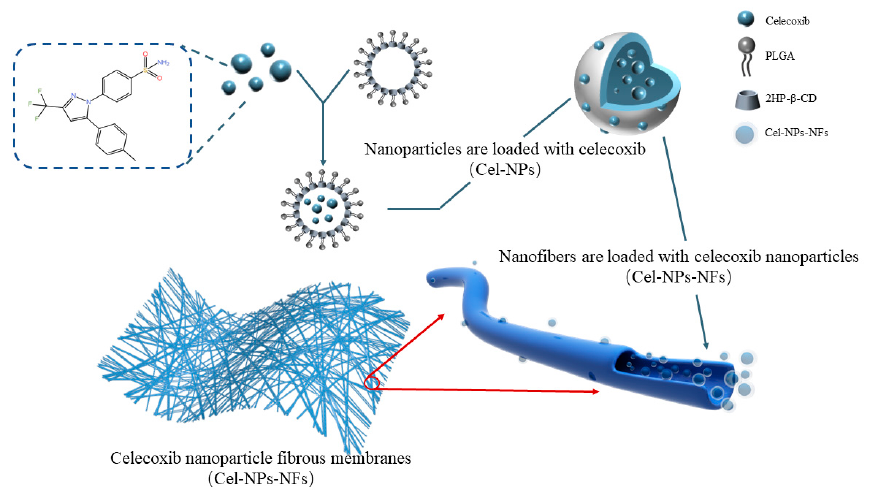
Figure 1. Schematic diagram of the mechanism of Cel-NPs-NFs preparation.